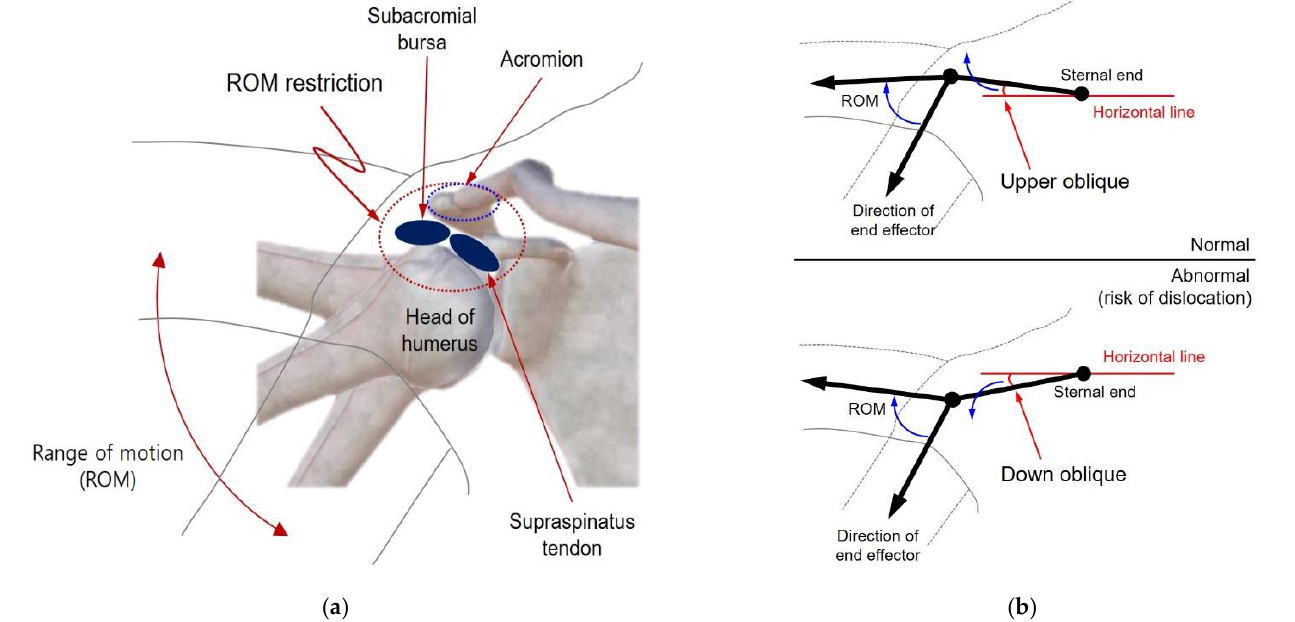
Figure 6. The biomechanical relationship between the shoulder and the acromioclavicular joint. ( a ) Anatomical structure of the shoulder joint and the acromioclavicular joint. ( b ) Normal or abnormal correlation of the inclination of the clavicle and shoulder rotation.